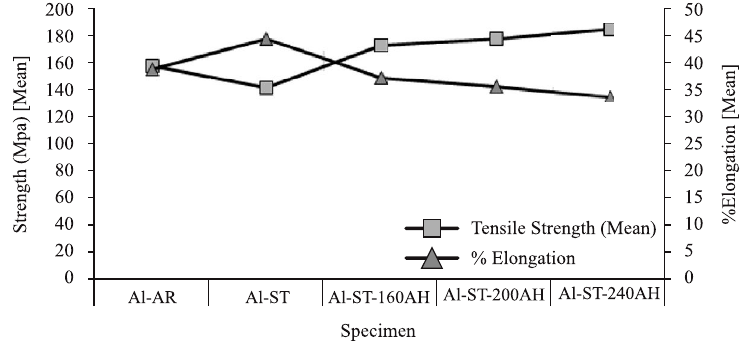
FIG. 3. RESULTS OF TENSILE STRENGTH (MPA) AND PERCENTAGE ELONGATION